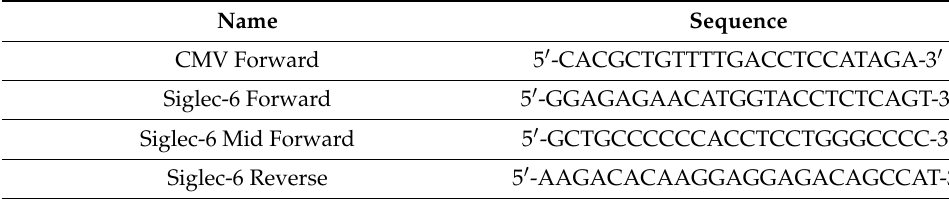
Table 2. Primers used for sequencing the DNA